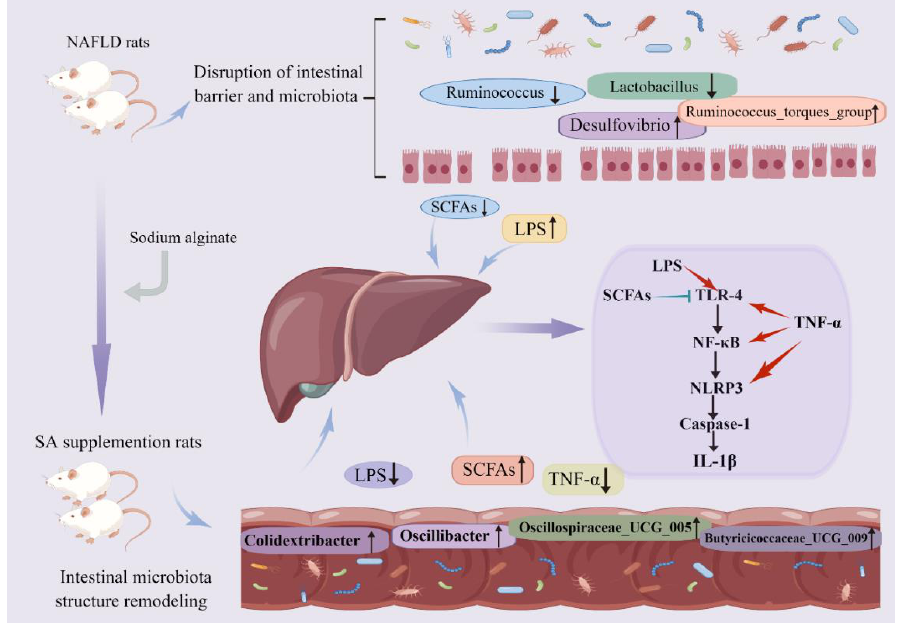
Figure 7. SA-alleviated inflammation by modulating the gut – liver axis in HFD-fed rats. The black upward arrows represent increase; the black downward arrows represent decrease; the red arrows represent promotion. Supplementary Materials: Table S1: Primers used during the real-time PCR assay. Figure S1: The ratio of TC/HDL-C. Figure S2 and S3: The alpha-diversity.